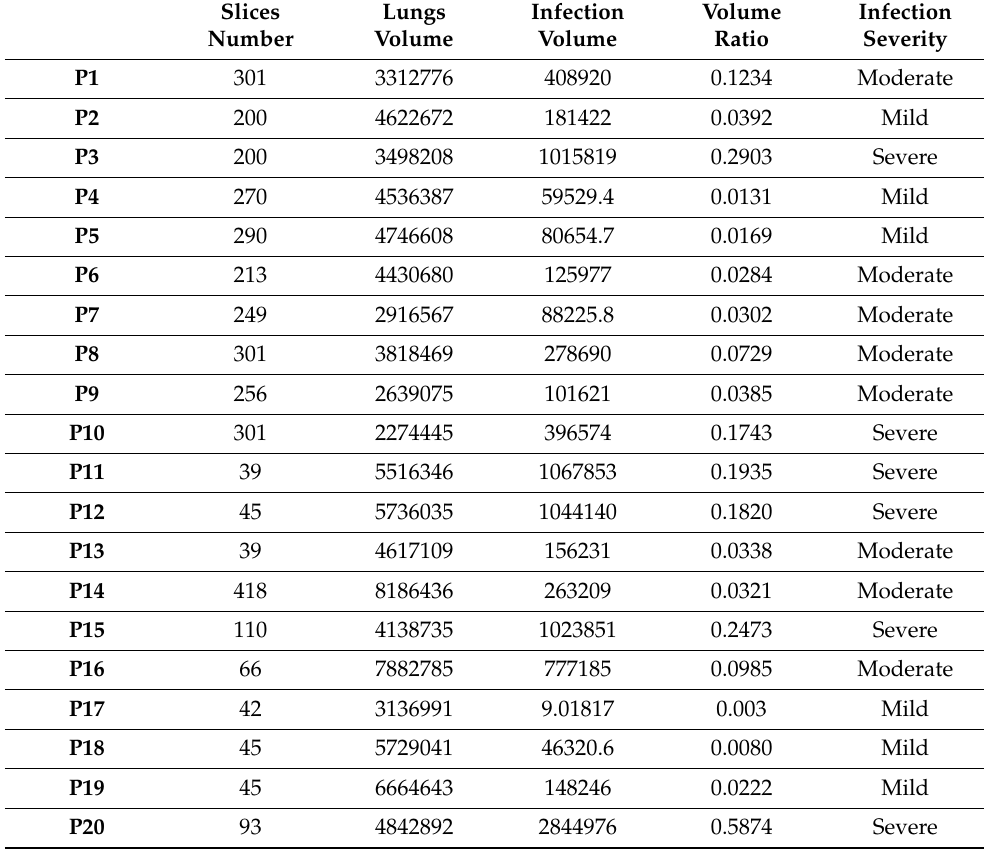
Table 3. Quantitative results of the volume reconstruction phase for three different patients from the used